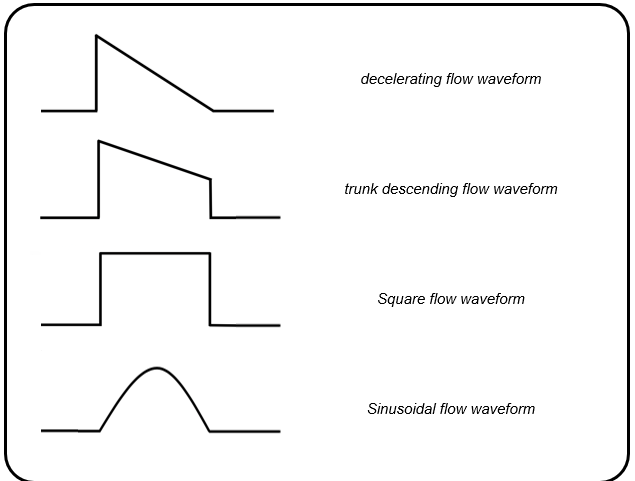
Figure 1. Schematic representation of the delivered inspiratory flow waveforms.